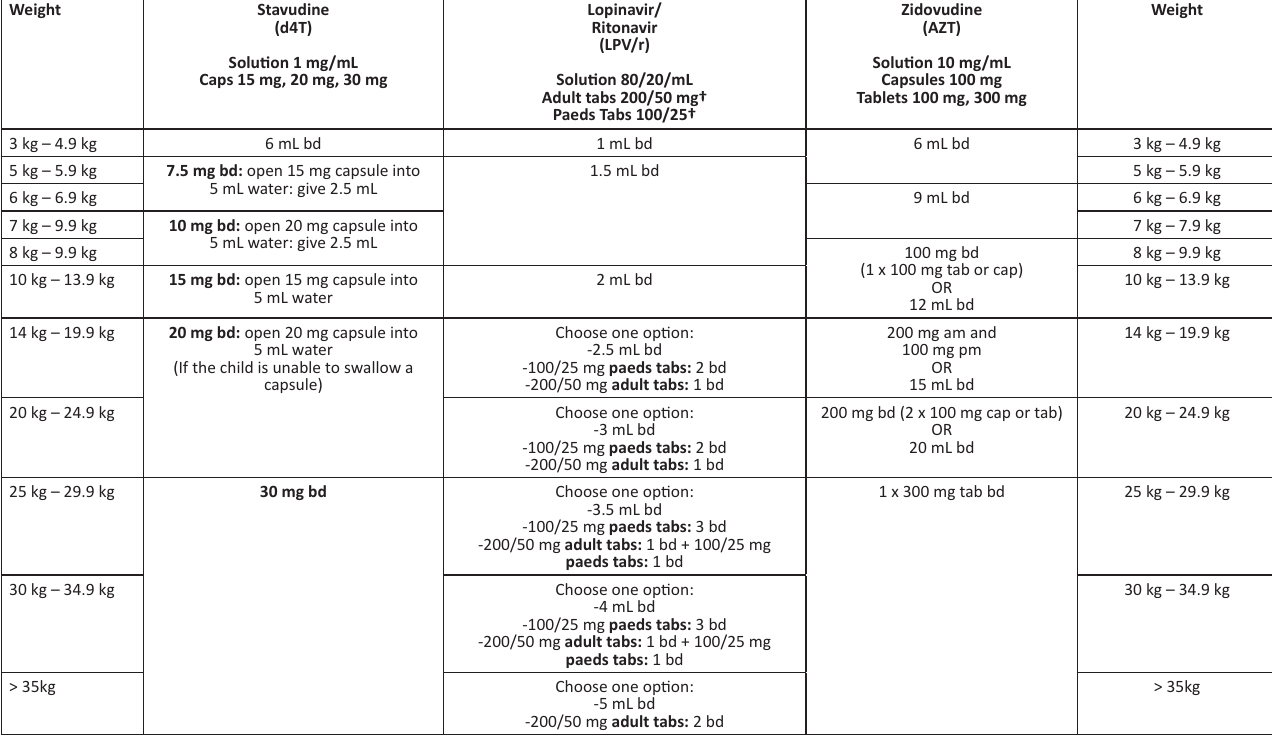
FIGURE 1-A1: Stavudine (d4T); Lopinavir/Ritonavir (LPV/r); Zidovudine (AZT). 1